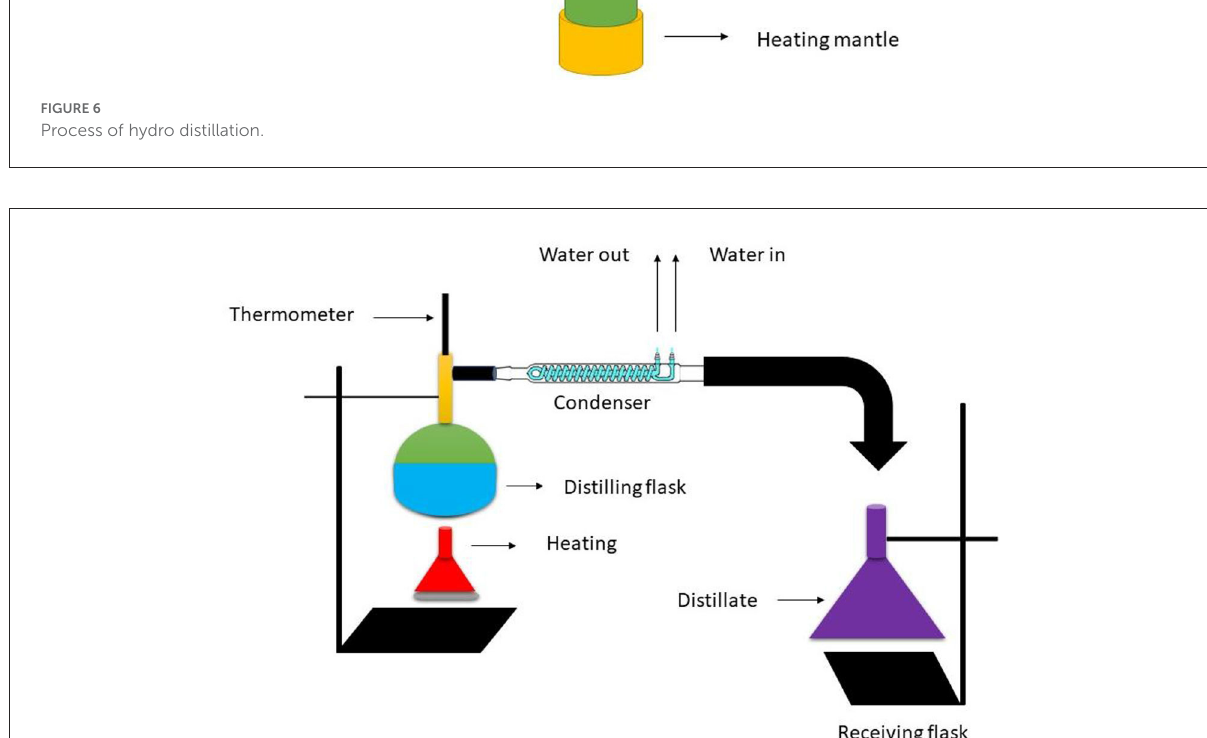
FIGURE7 Simple distillation